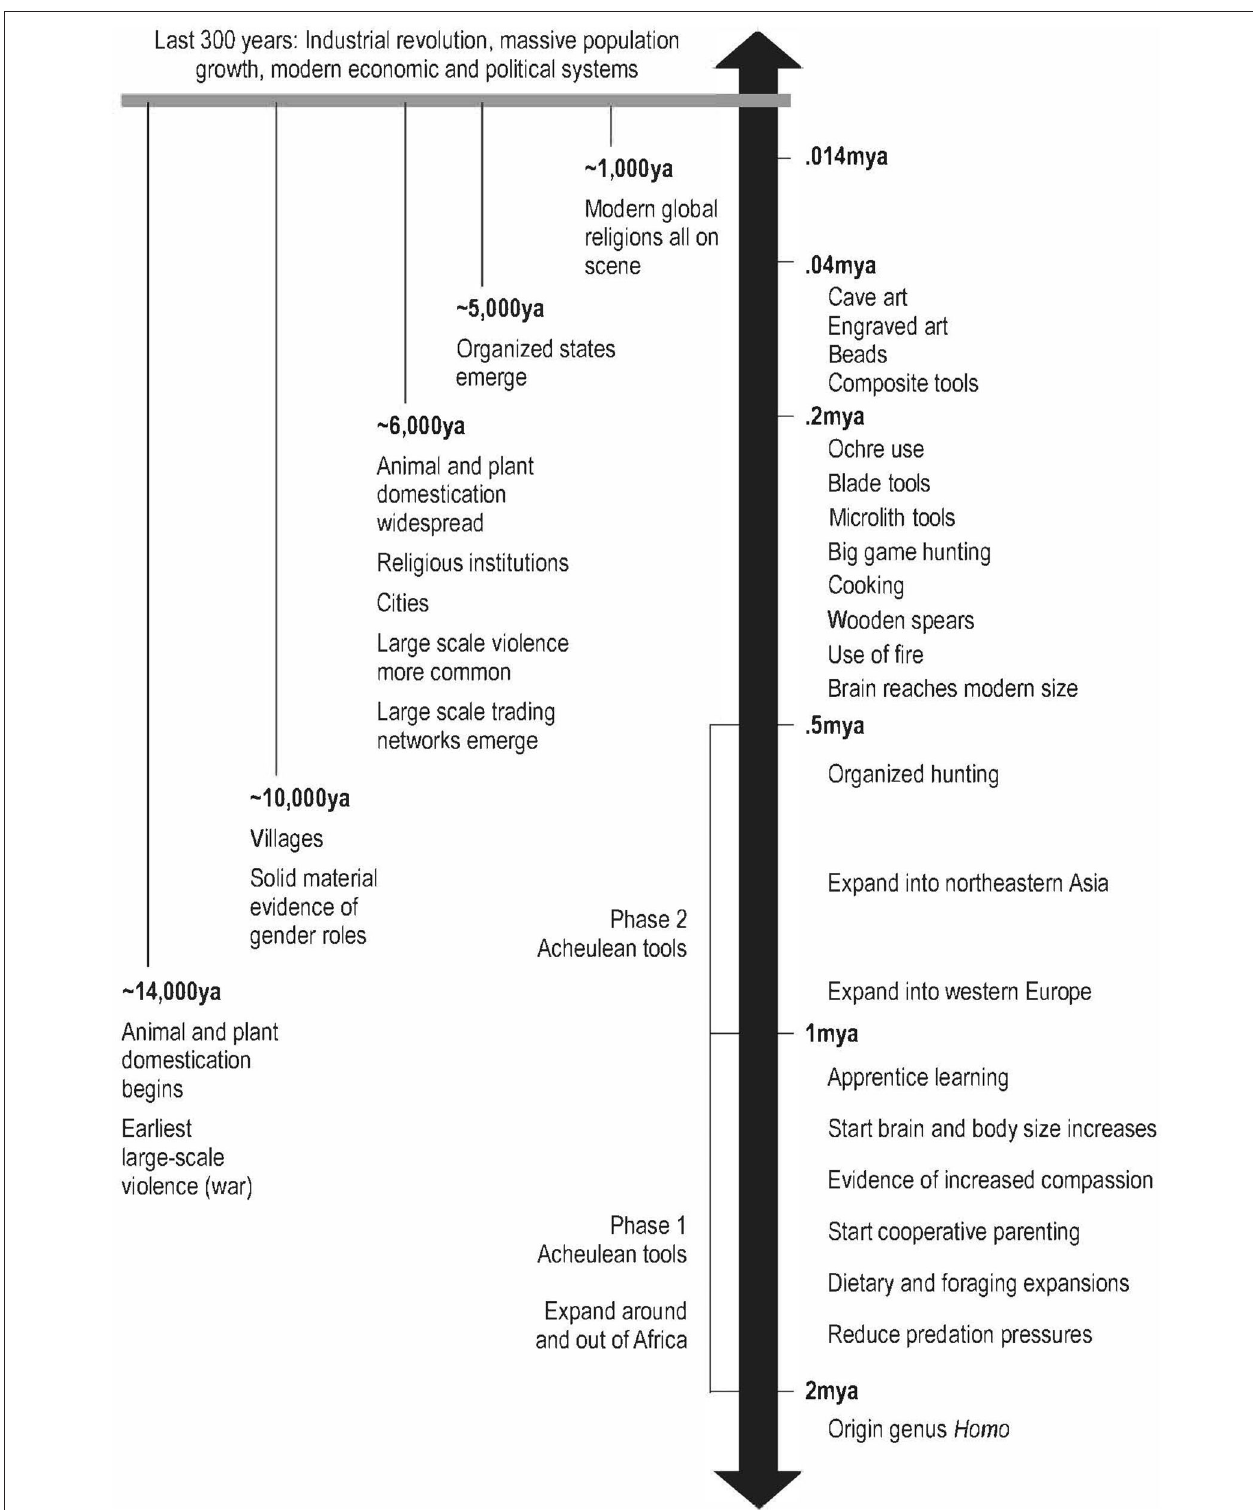
FIGURE 1 | A summary overview of the many key capacities, events and processes in the human niche dated to their first appearances in the fossil and archeological record. Reproduced from Fuentes, 2018, 2019, with permission from University of Chicago Press and Yale University Press.